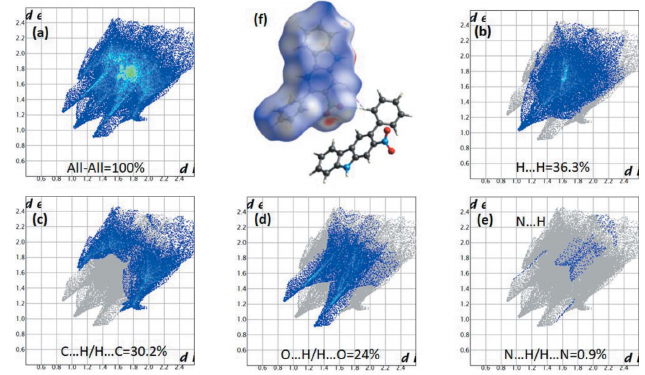
Figure 3 The Hirshfeld surface of the title compound mapped over d norm to visualize the intermolecular interactions.